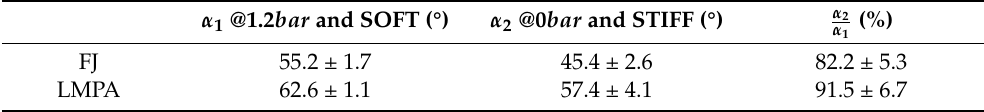
Table 4. The table summarizes the residual angles measured for the two